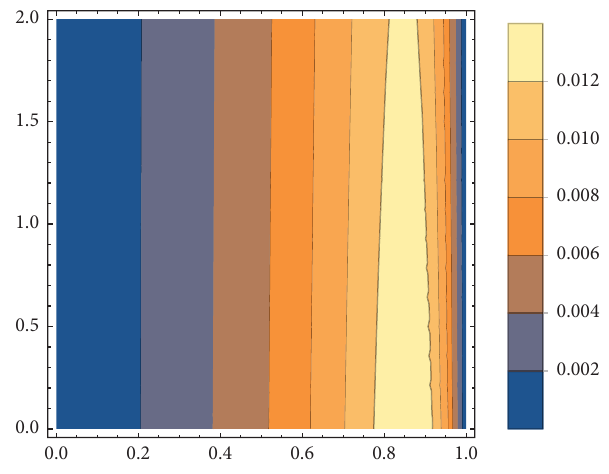
The contour plot for Figure 5 when a � 1 . 1 , μ � 0 . 001 , and N � 32 for Example 2.